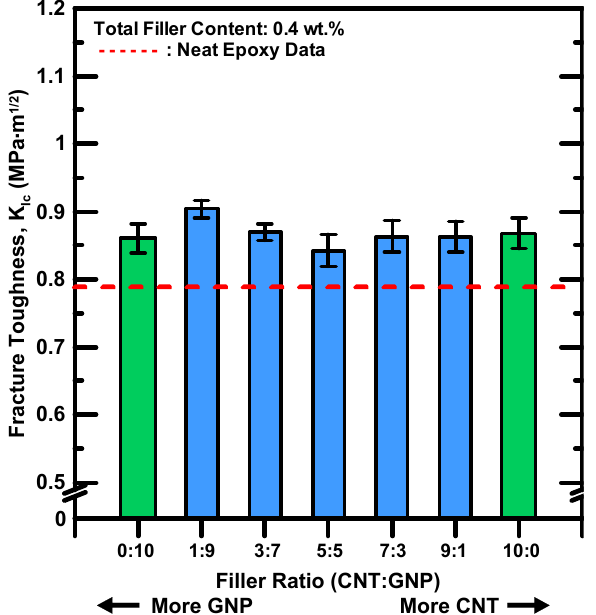
Figure 11. Variation of Mode I fracture toughness K IC of the studied nanocomposites with various filler ratios.